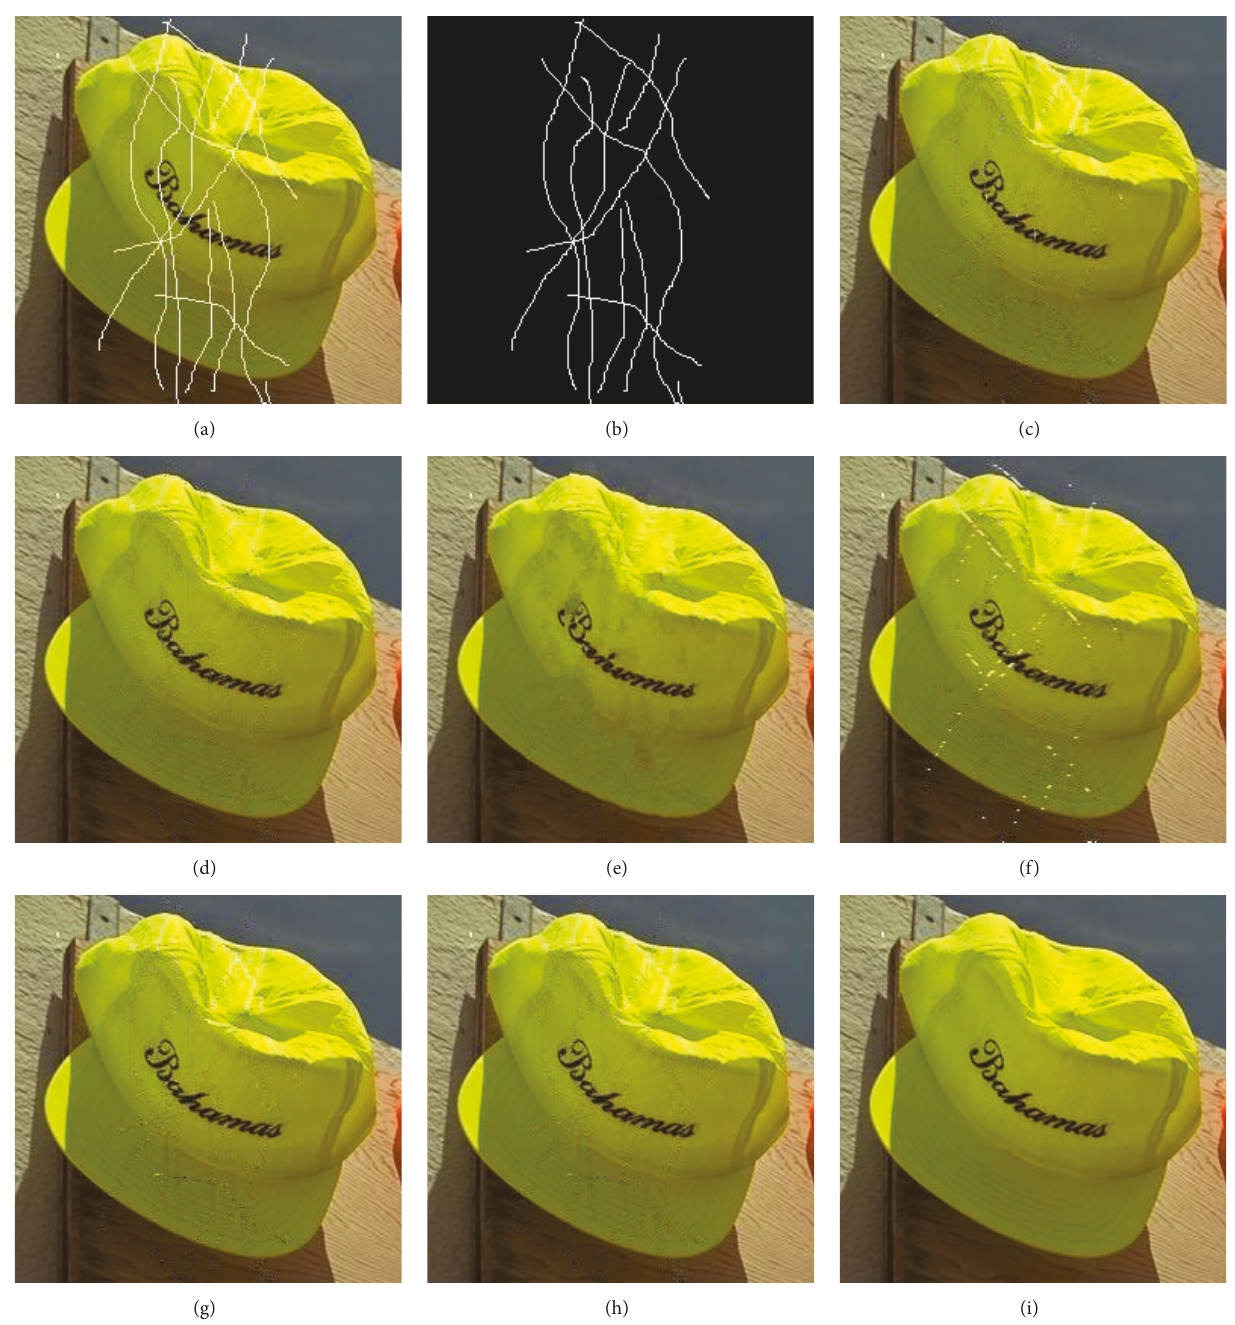
Figure 6: Repaired hat images by different inpainting methods. (a) The damaged image; (b) the mask image; (c) by BSCB; (d) by CT; (e) by EB; (f) by TV; (g) by Thiele; (h) by our method; (i) the original